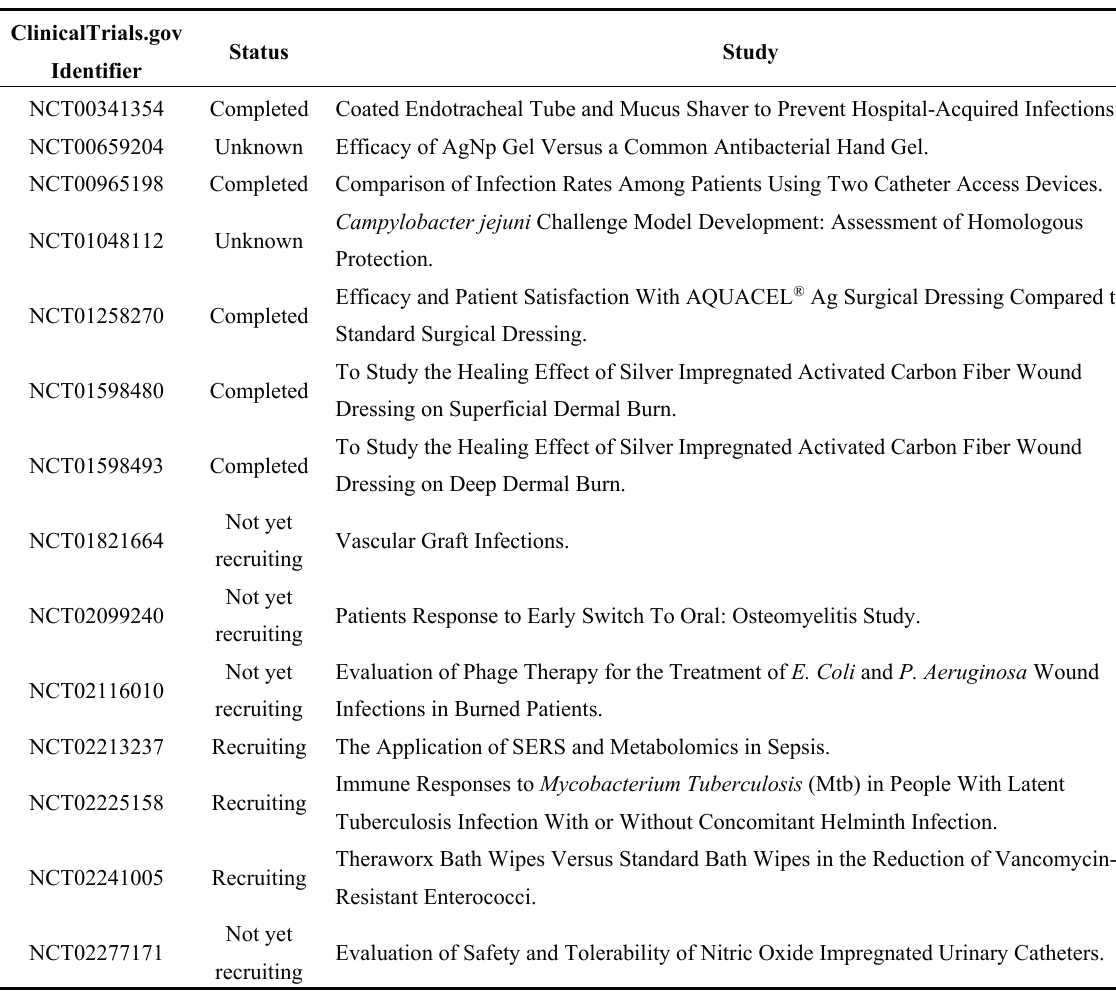
Table 3. AgNP clinical